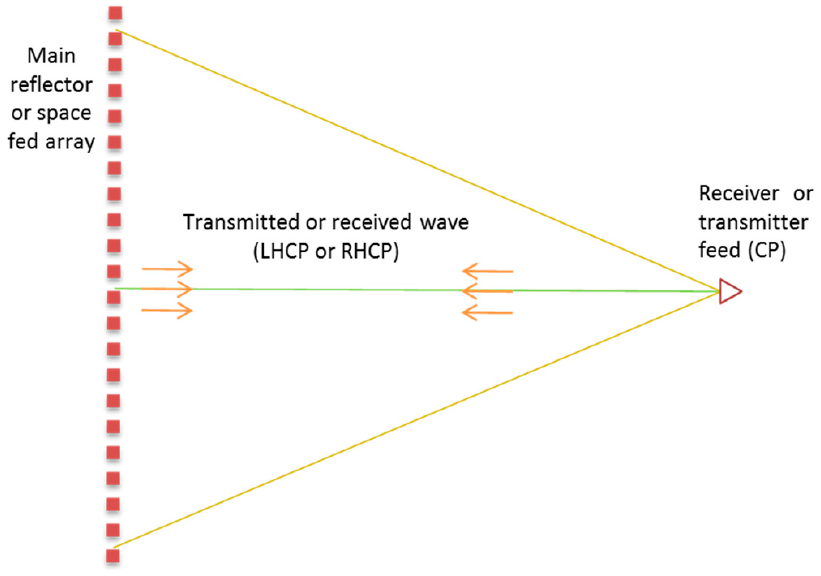
Figure 2. Schematic of reflectors or space fed arrays.